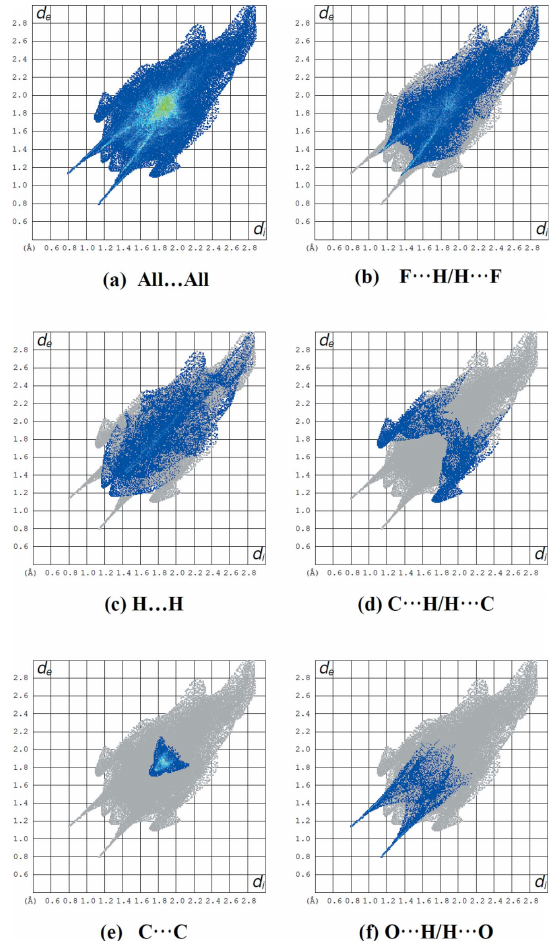
Figure 4 Two-dimensional fingerprint plots for the title compound showing ( a ) all interactions, and delineated into ( b ) F (cid:3)(cid:3)(cid:3) H/H (cid:3)(cid:3)(cid:3) F, ( c ) H (cid:3)(cid:3)(cid:3) H, ( d ) C (cid:3)(cid:3)(cid:3) H/ H (cid:3)(cid:3)(cid:3) C, ( e ) C (cid:3)(cid:3)(cid:3) C and ( f ) O (cid:3)(cid:3)(cid:3) H/H (cid:3)(cid:3)(cid:3) O interactions. The d i and d e values are the closest internal and external distances (in A˚ ) from given points on the Hirshfeld